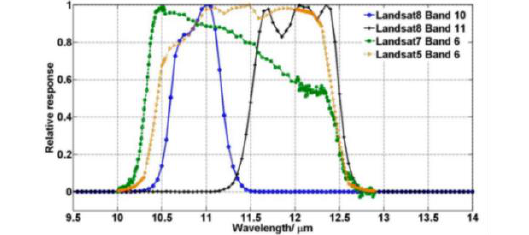
Figure 3: Relative spectral response for Landsat 5, 7 and 8 (Yu et al., 2014)